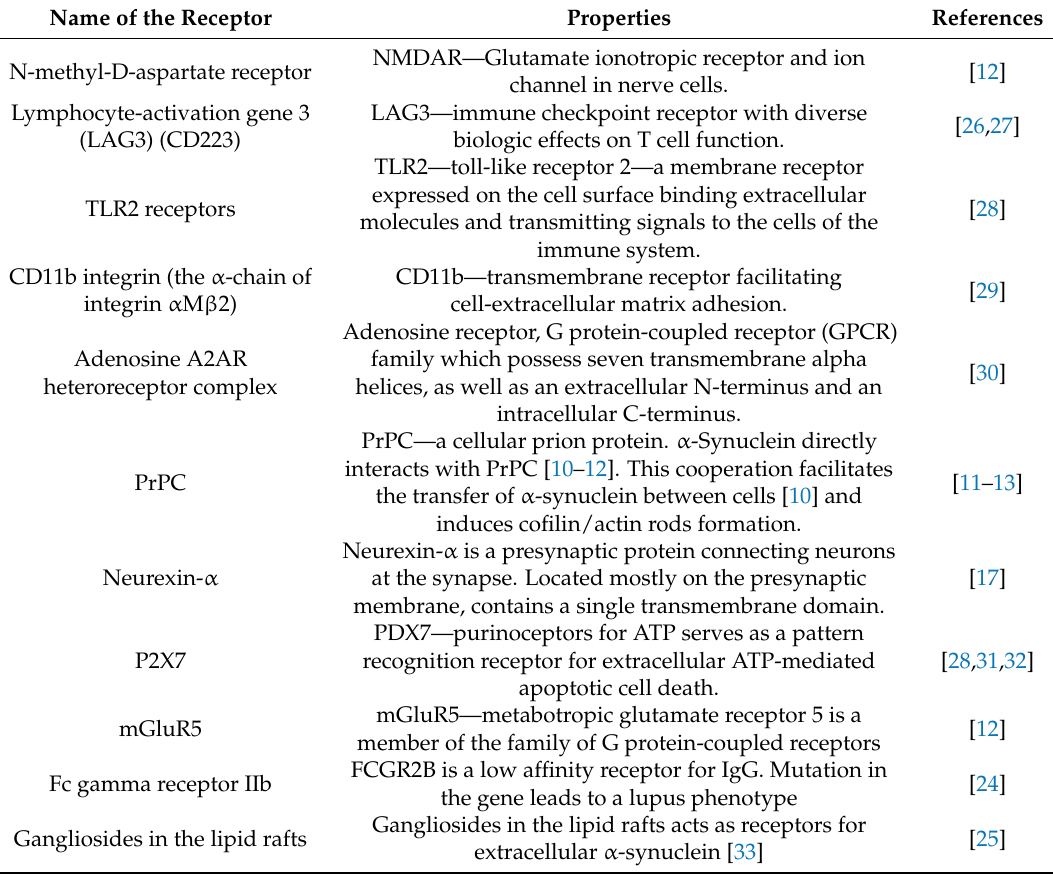
Table 1. Cell surface receptors binding extracellular α